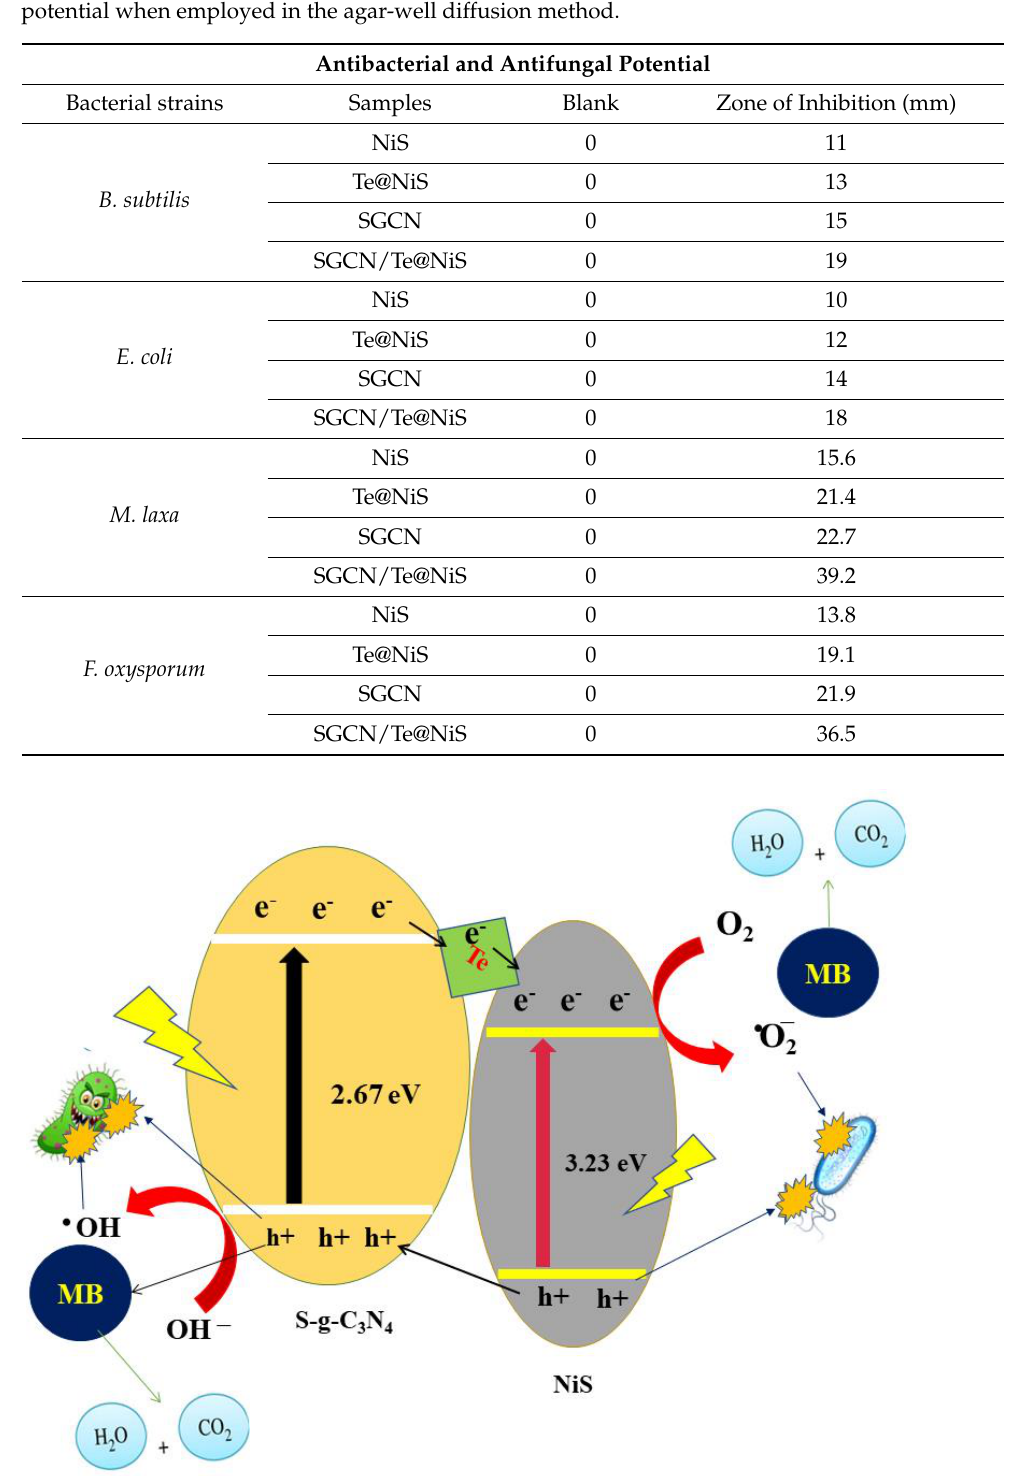
Figure 10. Schematic antimicrobial and catalytic dye degradation mechanisms under sunlight of the SGCN/Te@NiS